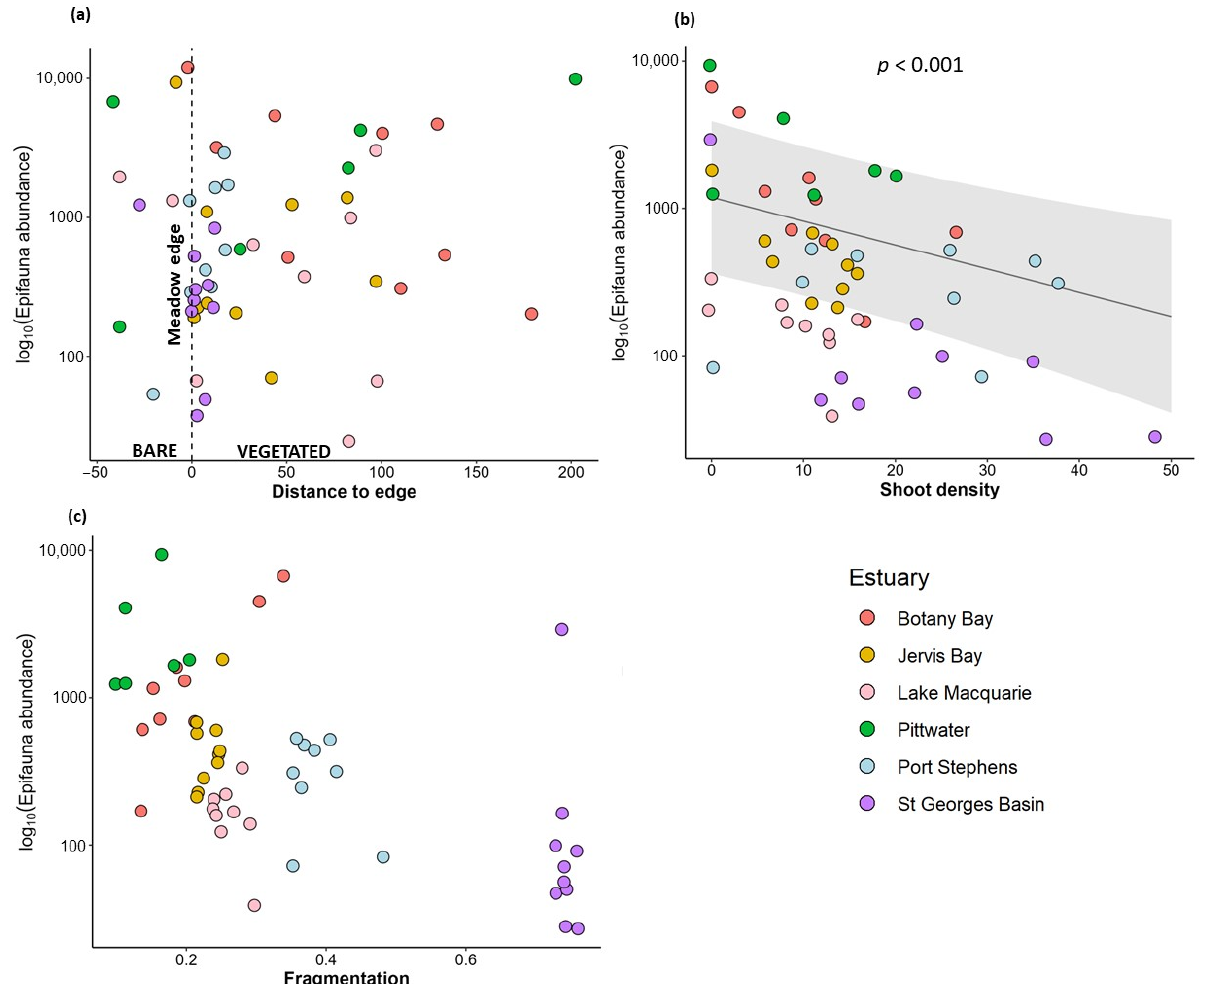
Figure 3. The relationships between abundance of epifauna and ( a ) distance to patch edge, ( b ) P. australis shoot density/0.0625 m 2 and ( c ) seagrass fragmentation. Sites on bare sediment have a negative value for distance to edge. Each point represents a sampling site, coloured by estuary, with the points jittered to avoid overplotting. Fitted lines are predictions ± 95% Coefficient Intervals from generalised linear mixed models. Table 1. Model outputs for each response variable after performing generalised linear mixed models including the 3 predictors as fixed factors and estuary as a random effect. Asterisks indicate signif-